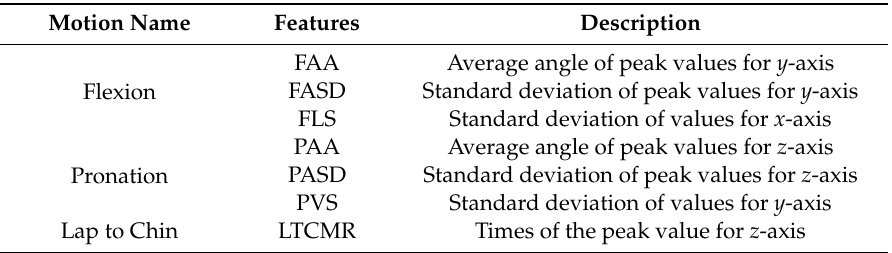
Table 1. Define motions Features.